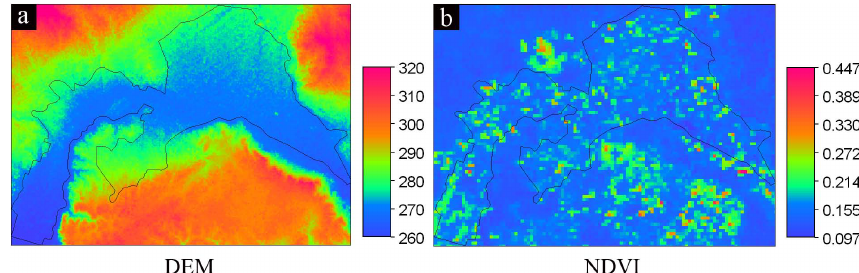
Fig. 2. (a) Digital Elevation Model (30m pixel resolution), and (b) NDVI map of the study area (250m pixel